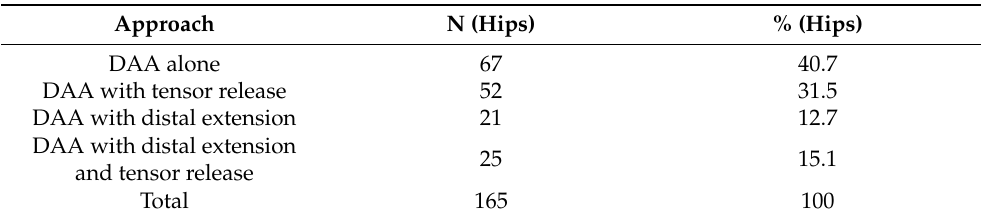
Table 1. Interval and approach extensions used for femoral stem revision with the Direct Anterior Approach (DAA).